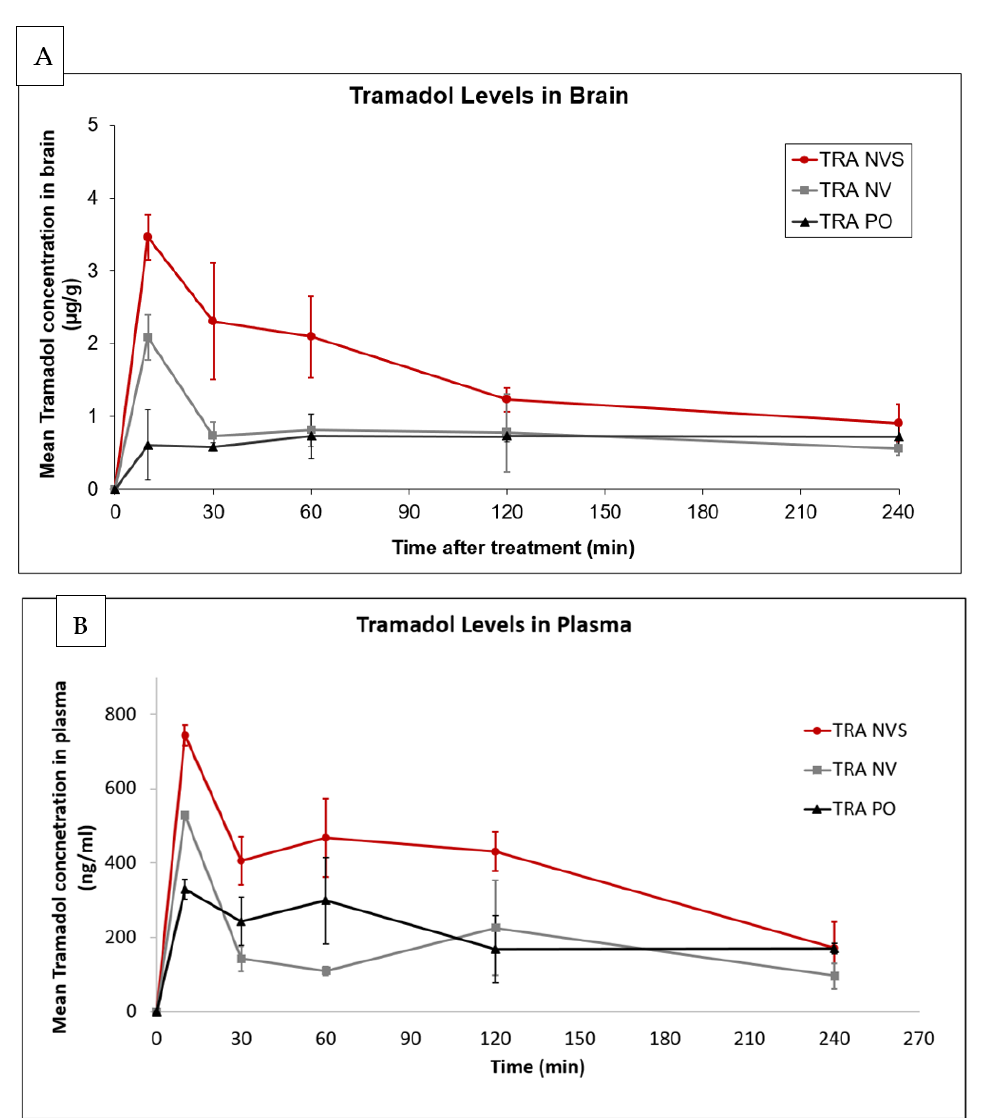
Figure 4. Pharmacokinetic profiles of Tramadol in ( A ) brain and ( B ) plasma following administration of the drug in the nasal nanovesicular system (TRA NVS) as compared to nasal non-vesicular system (TRA NV) and to oral administration (TRA PO), each at a drug dose of 7 mg/kg; mean ± SD; n, 5/group. ( A ) p < 0.01 for NVS vs. NV and 10, 30 and 60 min, and vs. PO at 10 min and 30 min; ( B ) p < 0.01 for NVS vs. NV and PO at 10–120 min.